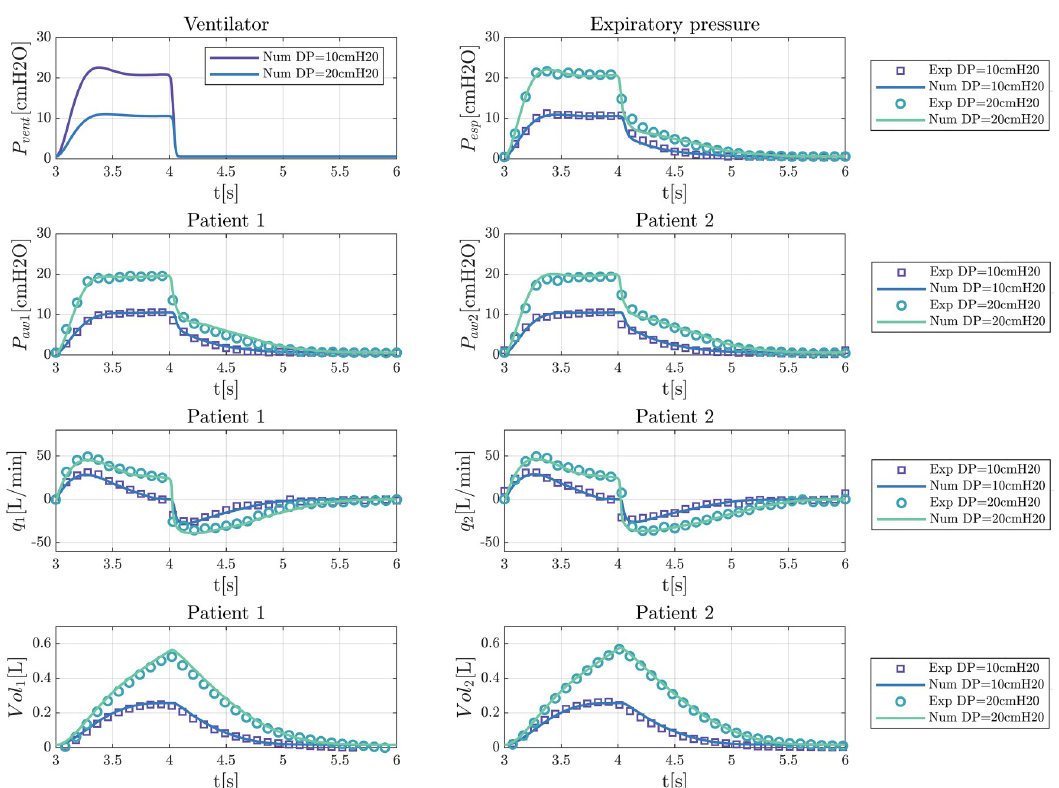
Fig 7. Validation tests for two driving